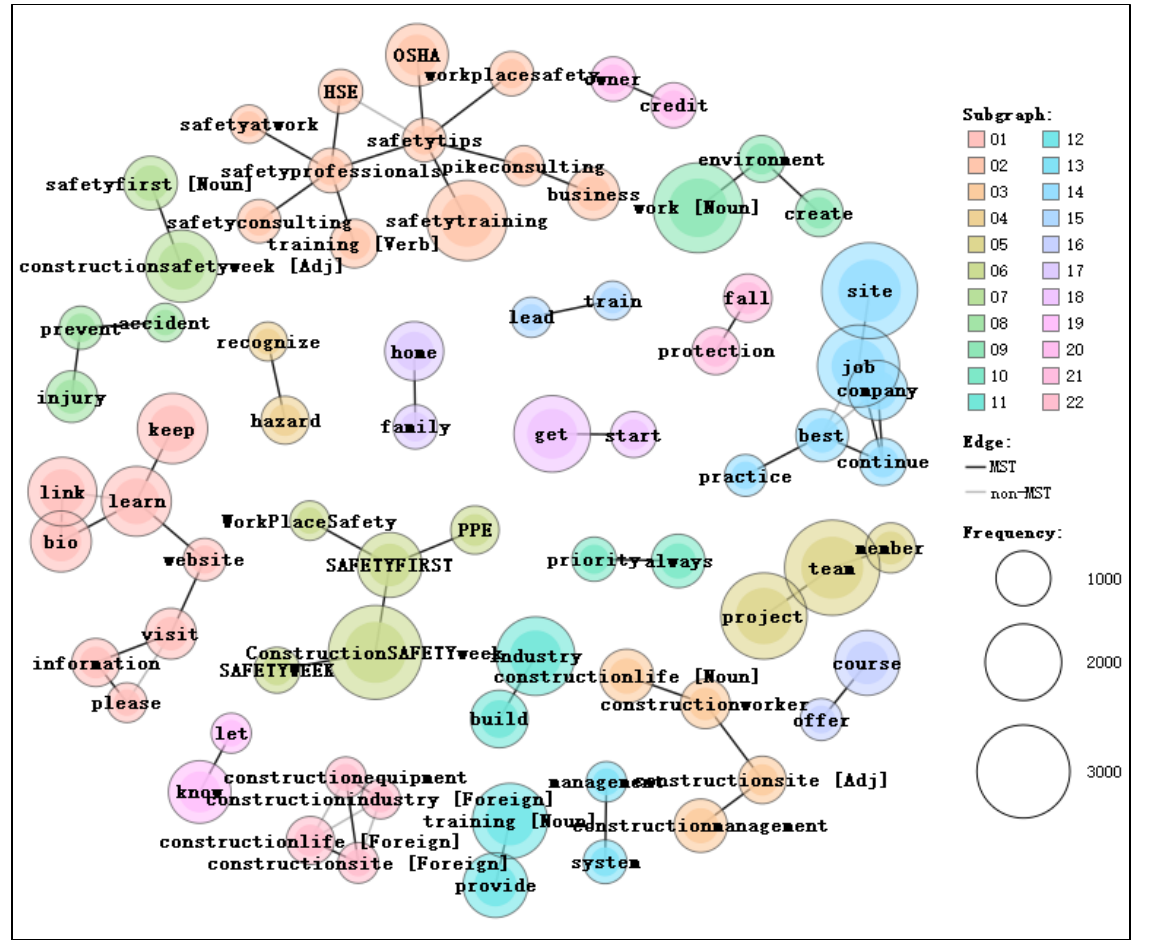
Figure 3. Co-occurrence network of words on construction health and safety on Instagram. Figure 3. Co‑occurrence network of words on construction health and safety on